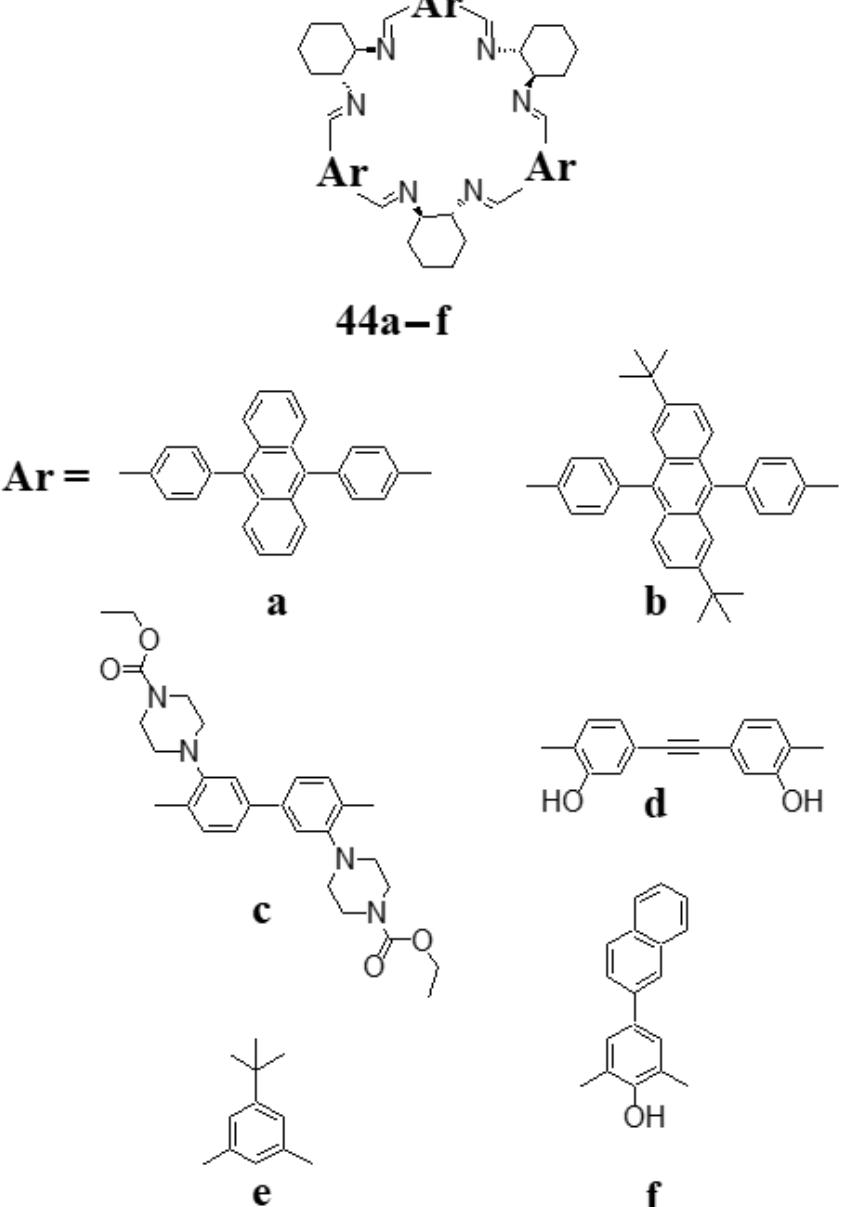
Figure 16. Examples of macrocyclic [3 + 3] imines derived from